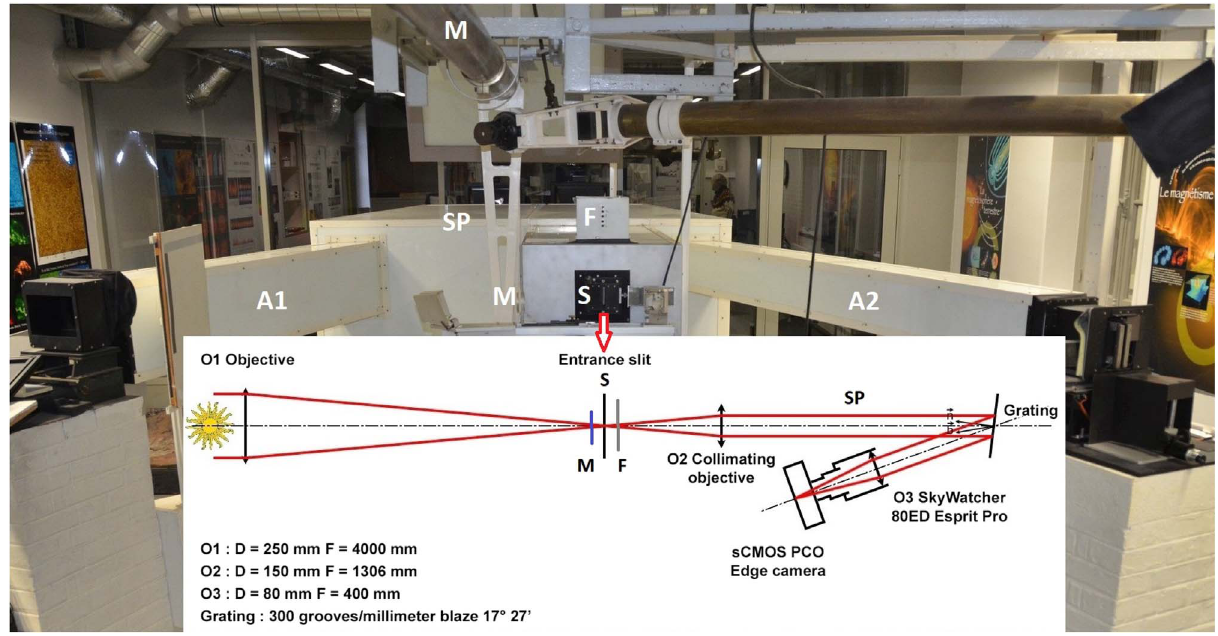
Fig. 5. The Spectroheliograph and optical scheme. S = entrance slit; SP = spectrograph; F = interference fi lters; M = neutral density “ moon ” translator for prominences; O1 = entrance objective and translator; O2 = collimator; O3 = chamber objective; A1, A2 = historical “ arms ” with old photographic 13 (cid:3) 18 cm plate systems.